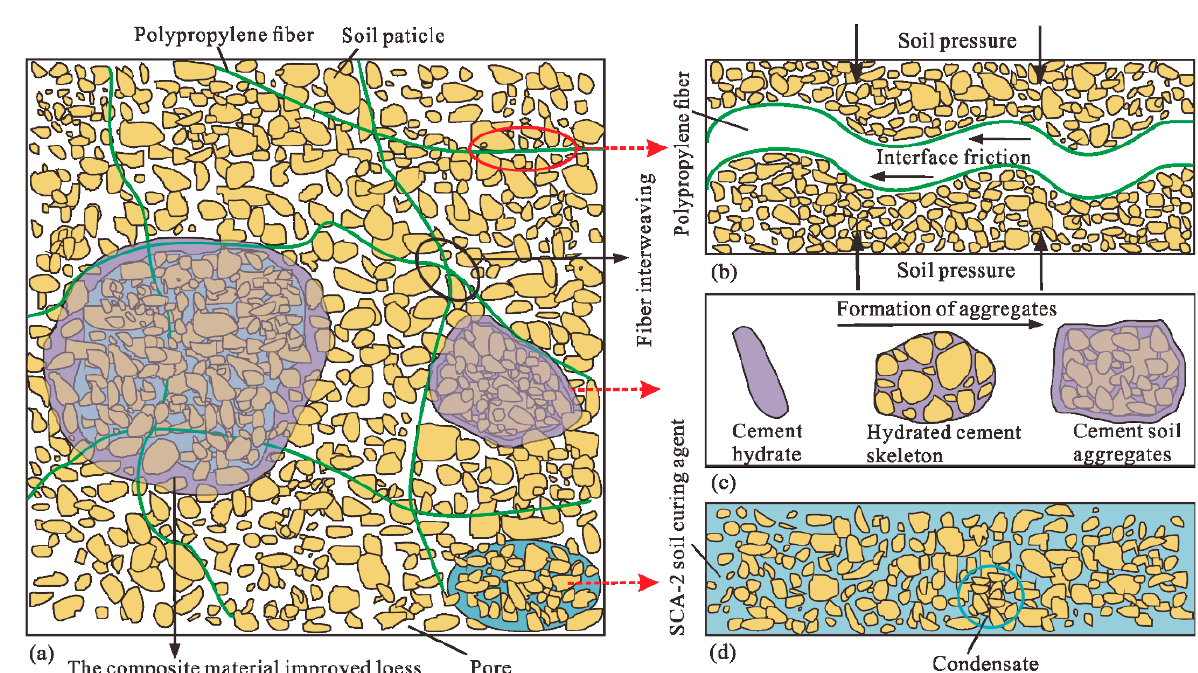
Figure 13. Microscopic schematic diagram of the mechanism of composite materials improving loess (modified from Yan et al. 2021). ( a ) General schematic diagram; ( b ) polypropylene fiber; ( c ) cement; ( d ) SCA-2 soil curing agent.